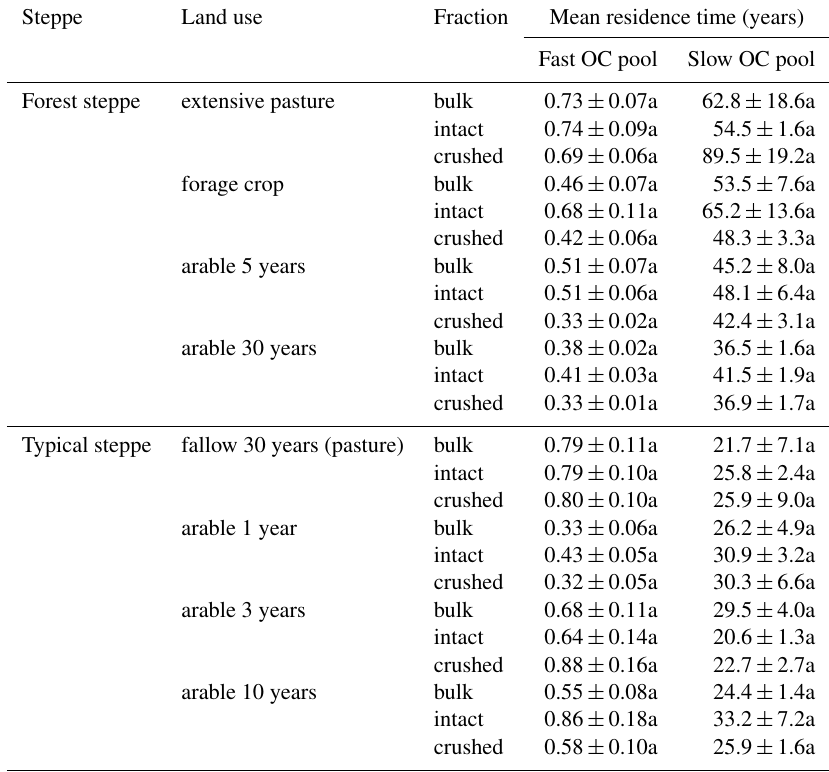
Table 2. Mean residence times of the fast and slow OC pool (years) as arithmetic mean ± standard error (SE), as derived from least-square fitting of incubation data, for two steppe types and as function of land use and soil fraction. Significant differences ( p < 0 . 05) between fractions within land use were not detected, which is indicated by same lowercase